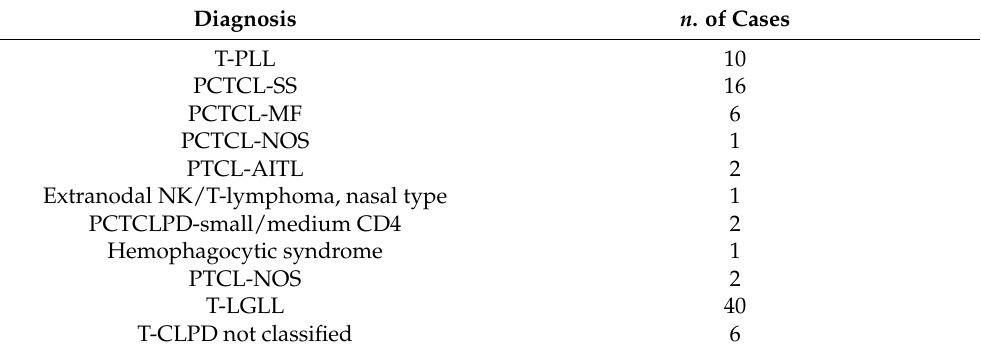
Table 1. Number of T-CLPD cases ( n = 87), analyzed according to their WHO2017 diagnosis. Diagnosis n . of Cases T-PLL